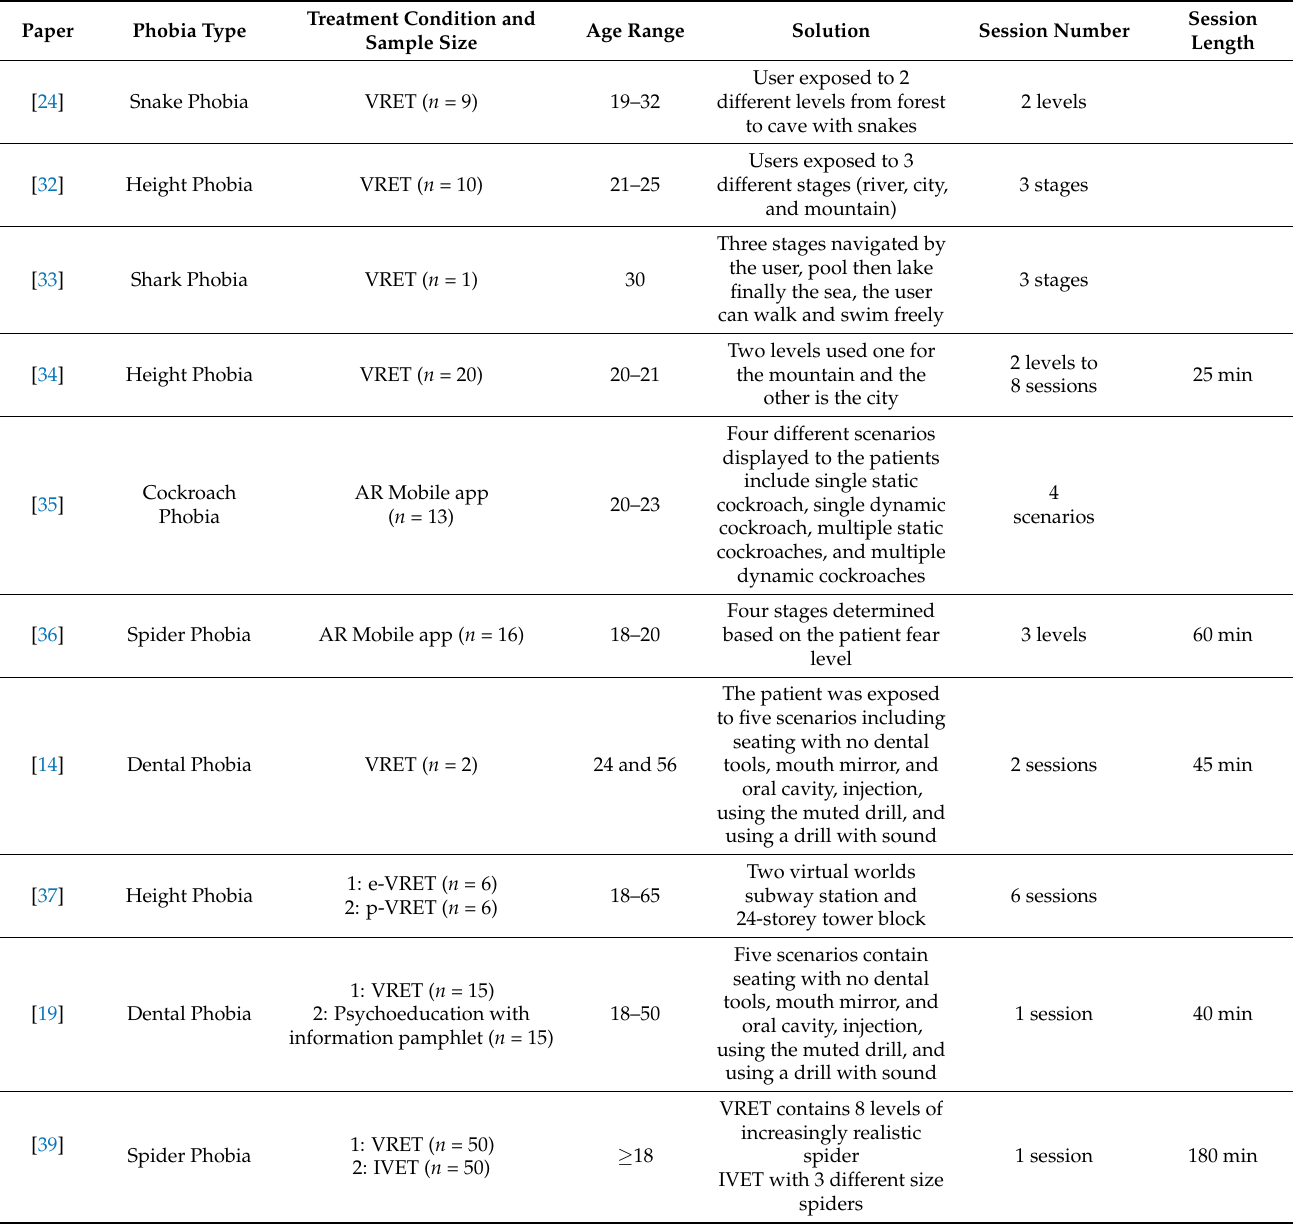
Table 5. Existing augmented reality and virtual reality exposure therapy for specific phobia